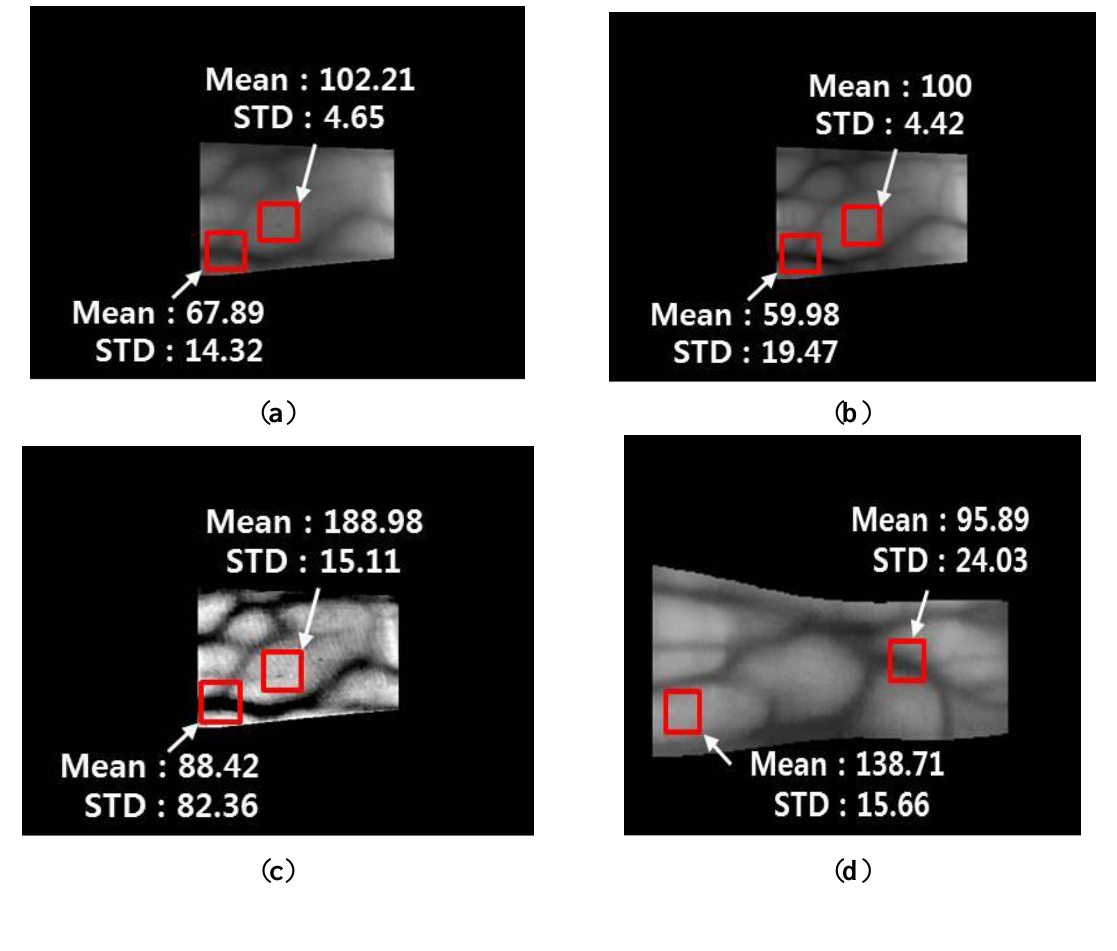
Figure 18. Comparison of the mean and STD values of the vein line and skin region using the proposed method with an image from database I: ( a ) original image of the detected finger boundaries; ( b ) Gabor filtered image; ( c ) Retinex filtered image with a sigma value of 20; and ( d ) image produced using the fuzzy-based fusion method with LOM and the Min rule (proposed